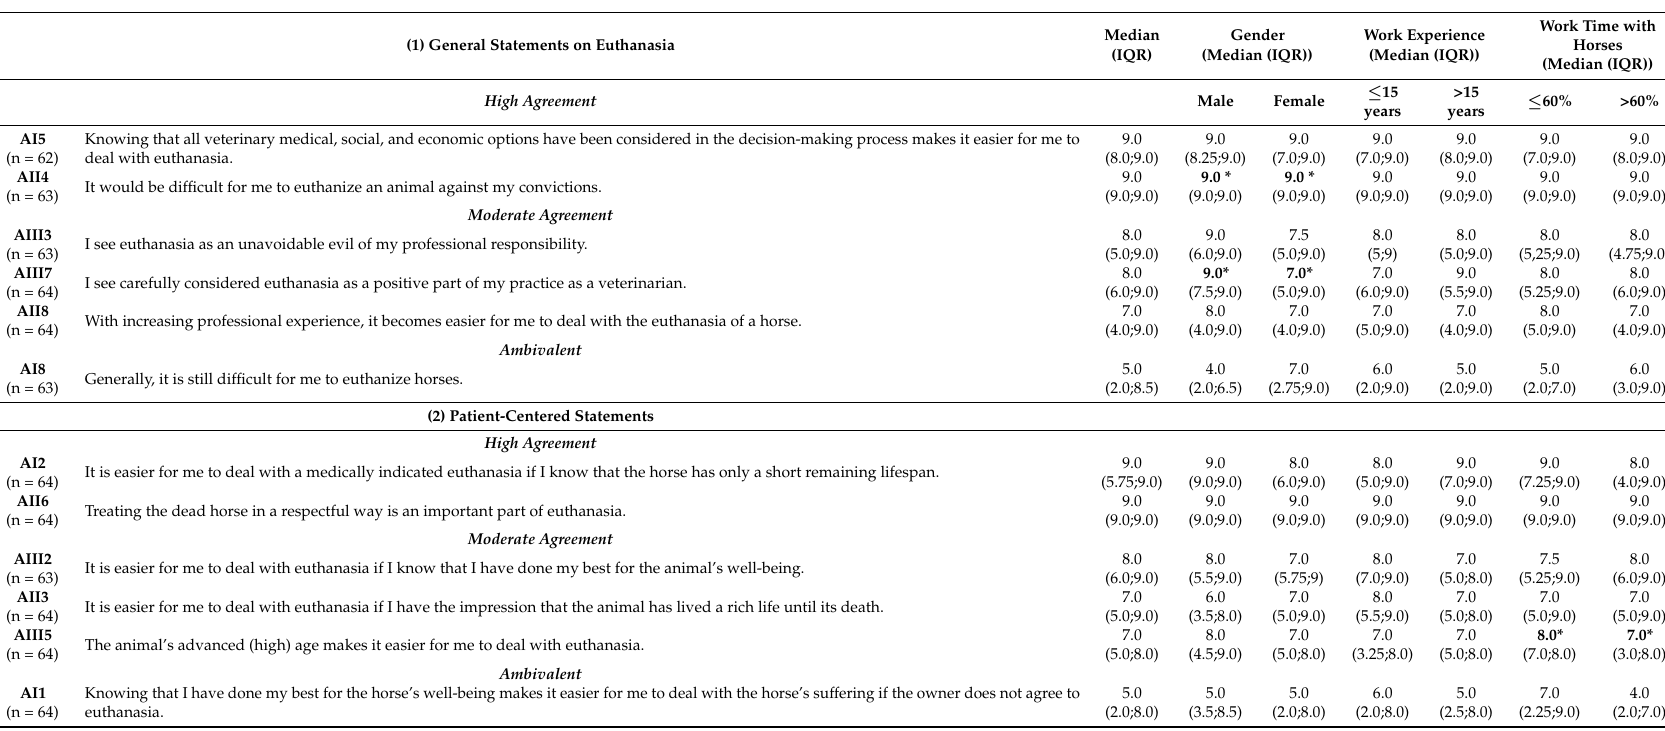
Table 2. Veterinarians’ level of agreement with 25 normative and descriptive statements in the context of euthanasia in equine practice (thematically